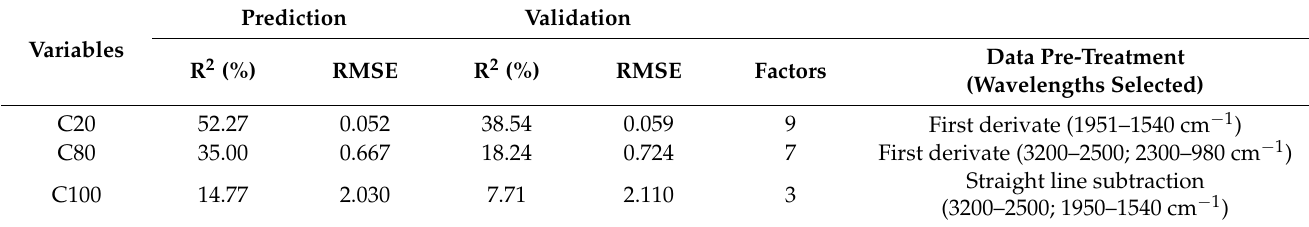
Table 2. Results of the prediction and validation optimized models for each variable